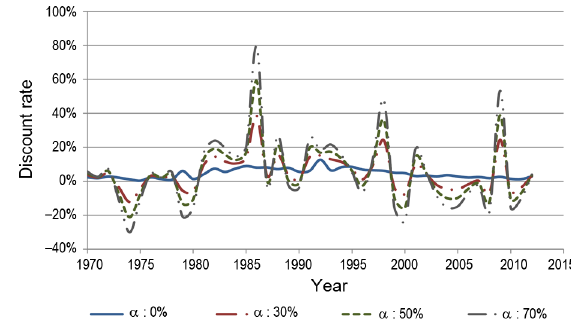
Fig. 3. The average equivalent discount rates based on the historical data for Sweden